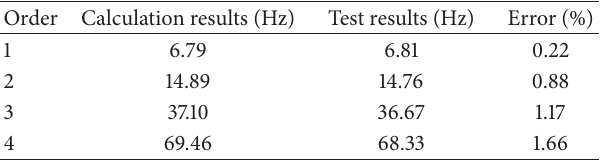
Table 5: Natural frequencies compared between calculation results (using identified stiffness) and test